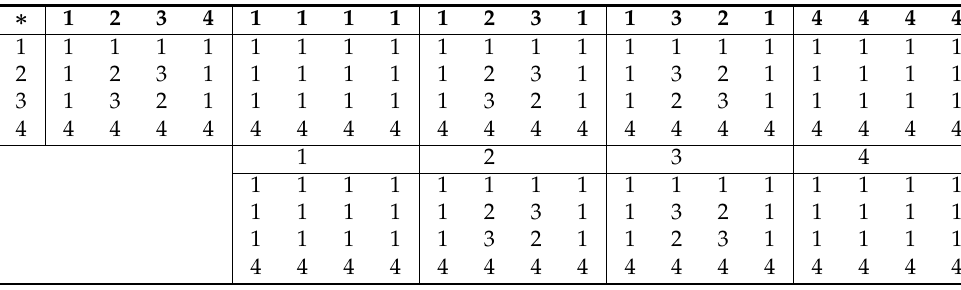
Table 2. Extended table of Example